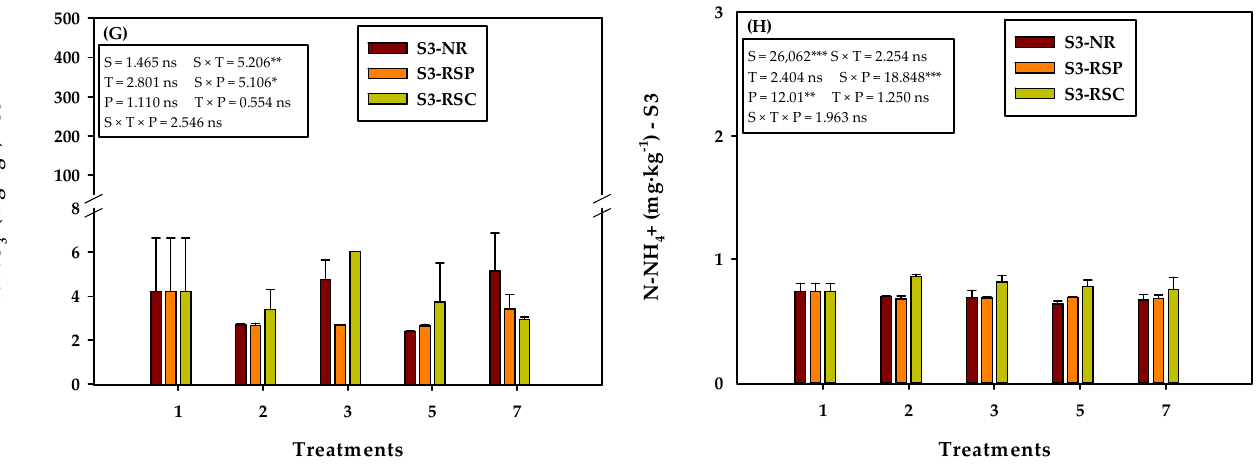
Figure 4. Mean concentration of total TN ( A,E ), N-NO 2 − ( B,F ), N-NO 3 − ( C,G ) and N-NH 4+ ( D,H ) in the different treatments (1, 2, 3, 5 and 7): 1: control; 2: limestone and biochar; 3: limestone and compost; 5: biochar, limestone and zeolite and 7: limestone, biochar, compost and zeolite. S2: sampling 2; S3: sampling 3. NR: non-rhizosphere soil; RS: rhizosphere soil; P: P. miliaceum ; C: C. juncea . Error bars denote standard deviation ( n = 3). F values and significance of the two-way repeated measures ANOVA are shown in each graph. S: soil type; T: treatment; P: plant type. Significant at * p < 0.05, ** p < 0.01 and *** p < 0.001; ns: not significant ( p > 0.05). ( A ) Mean concentration of TN in the different treatments (1, 2, 3, 5 and 7). ( B ) Mean concentration of N-NO 2 − in the different treatments (1, 2, 3, 5 and 7). ( C ) Mean concentration of N-NO 3 − in the different treatments (1, 2, 3, 5 and 7). ( D ) Mean concentration of N-NH 4+ in the different treatments (1, 2, 3, 5 and 7). ( E ) Mean concentration of TN in the different treatments (1, 2, 3, 5 and 7). ( F ) Mean concentration of N-NO 2 − in the different treatments (1, 2, 3, 5 and 7). ( G ) Mean concentration of N-NO 3 − in the different treatments (1, 2, 3, 5 and 7). ( H ) Mean concentration of N-NH 4+ in the different treatments (1, 2, 3, 5 and 7).